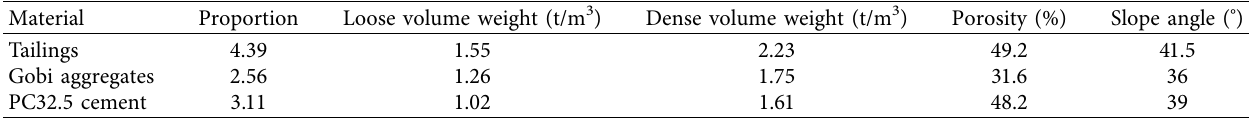
Table 2: Physical properties of filling materials.